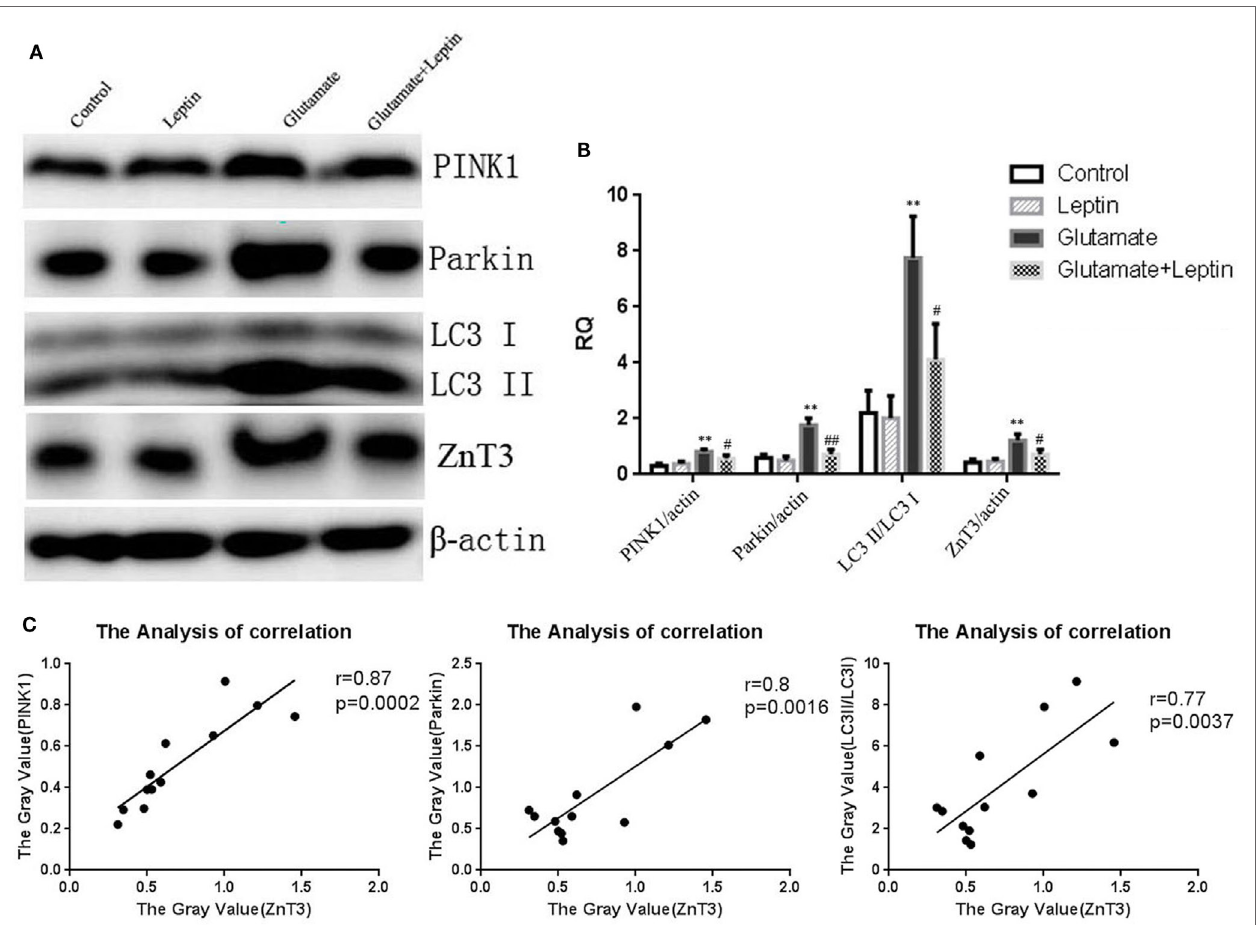
FigUre 7 | The effect of leptin on glutamate-triggered expressions of mitophagy protein and zinc transporter 3 (ZnT3). (a) Western blot assay of expressions of mitochondrial autophagy protein and ZnT3 in HT22 cells; (B) the relative expression (integral optical density) of mitochondrial autophagy protein and ZnT3 in HT22 cells; (c) the analysis correlation between ZnT3 and mitophagy-related proteins * P < 0.05, ** P < 0.01, compared to the control group; # P < 0.05, ## P < 0.01, compared to the Glutamate